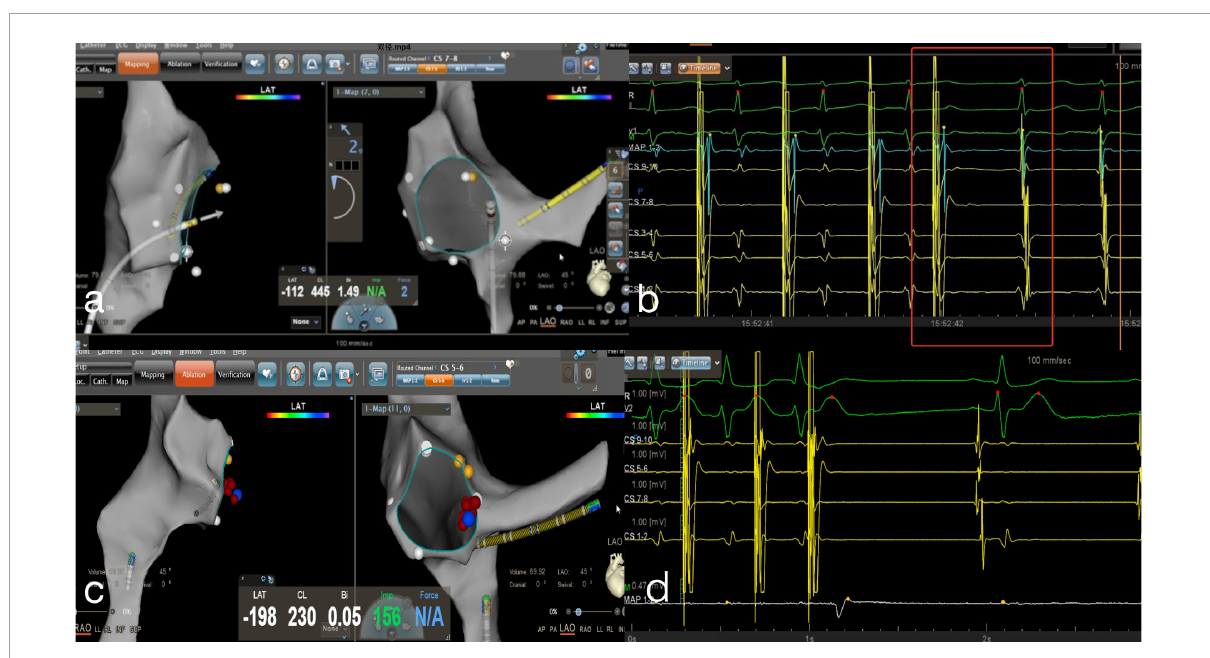
FIGURE3 Zero-fluoroscopy radiofrequency ablation for AVNRT. (a) Modeling of the right atrium was performed with a Decanav catheter using CARTO 3 system. The Decanav catheter the apex of the right ventricle. (b) An electrophysiology study showed AH/AV jumping. The slow-fast type of AVNRT was diagnosed. (c) The level of the lower portion of the coronary sinus ostium was suggested to be the slow pathway location. (d) AV node jumping disappeared, and AVNRT was not induced. AV, atrioventricular; AVNRT, AVNRT, atrioventricular nodal reentrant